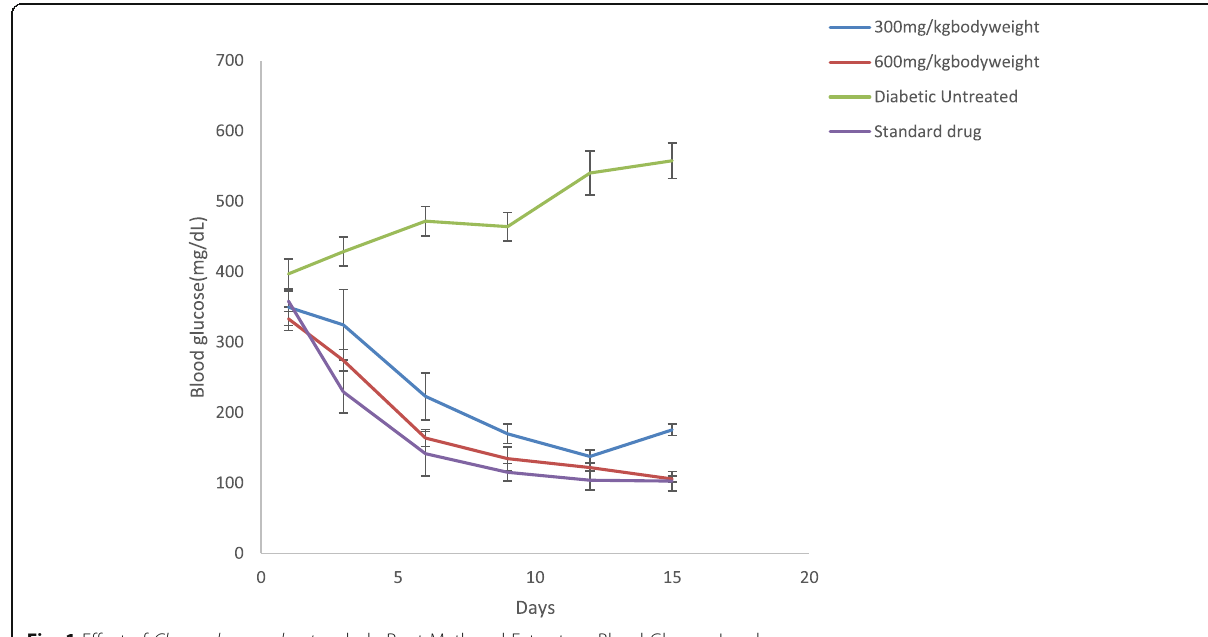
Fig. 1 Effect of Chromolaena odorata whole Root Methanol Extract on Blood Glucose Level